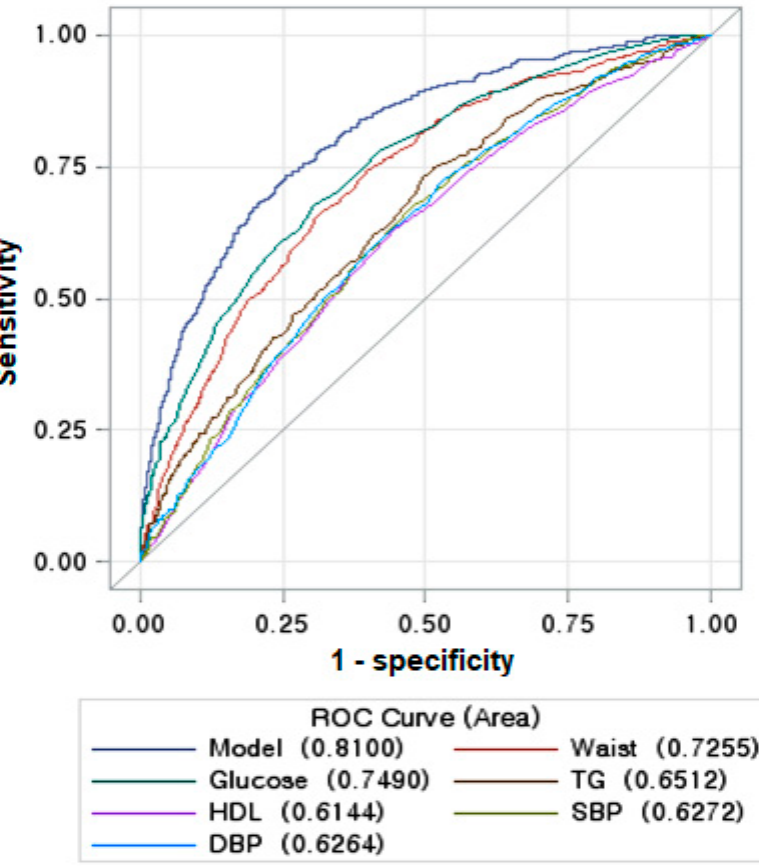
Figure 2. Receiver operating characteristic (ROC) curve with insulin resistance and metabolic syn- drome components for the metabolic syndrome risk. Table 3. The area under the curve (AUC) of the receiver operating characteristic (ROC) curve, accuracy, and k-fold of prediction models generated from machine-learning algorithms in the Ansan/Ansung